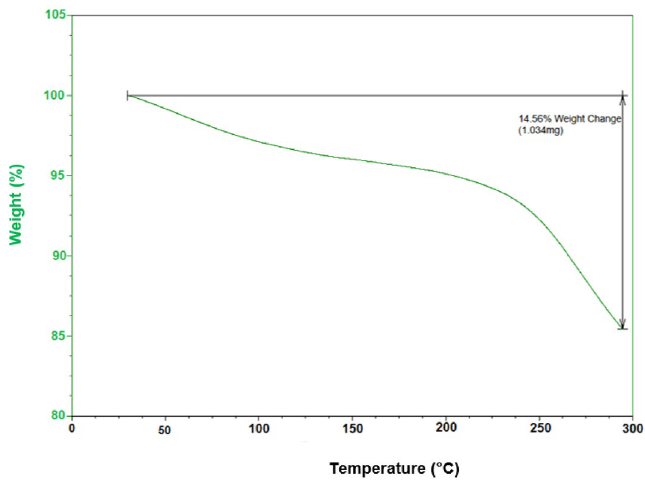
Figure 8. Thermal gravimetric analysis pattern of FNAOSiPAMP/Cu II